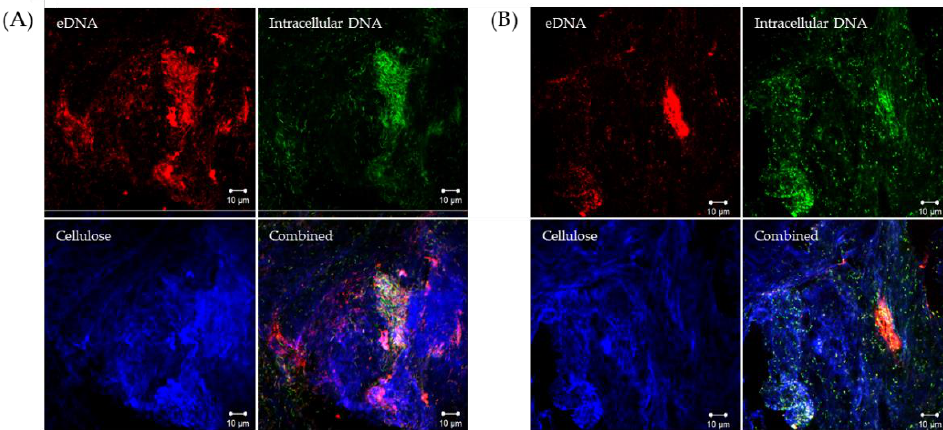
Figure 1. P. fluorescens SBW25 biofilms include eDNA. Confocal laser scanning microscopy (CLSM) was used to visualize eDNA, intracellular DNA, and cellulose in 24 h biofilms. Shown here are single-channel and combined CLSM images from Viscous Mass ( A ) and Wrinkly Spreader ( B ) biofilms. Propidium iodide (red channel) was used to visualize eDNA, CYTO9 (green channel) to visualize the intracellular DNA of live cells, and Calcofluor white (blue channel) to visualize cellulose, respectively, and all three channels are combined in the bottom-right image. The scale bars indicate 10 µm.